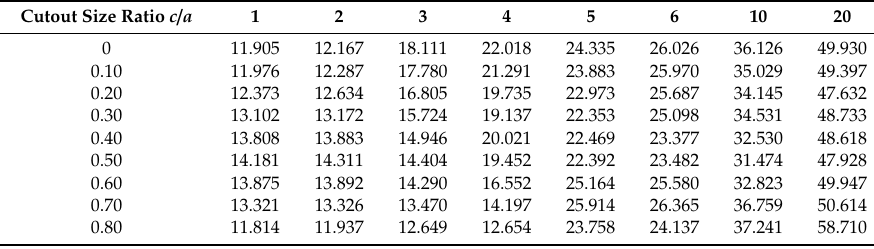
Table 8. Some of the first 20 frequency parameters Ω of cross-ply (0 ◦ / 90 ◦ / 90 ◦ / 0 ◦ ) laminated square plate with di ff erent cutout sizes under CSCS boundary